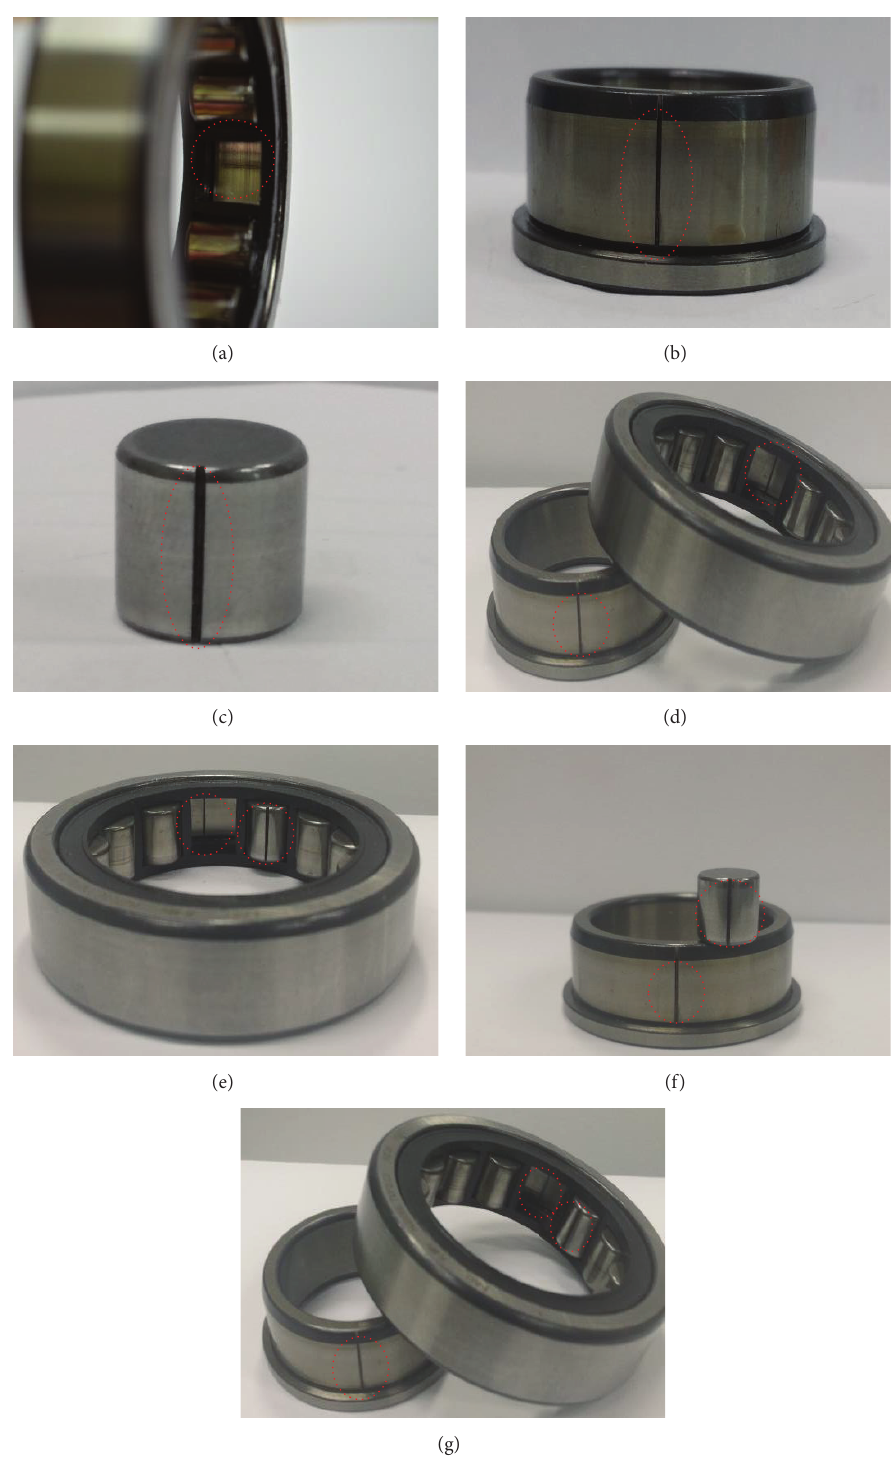
Figure 5: Single and multiple-combined bearing defects. (a) BCO, (b) BCI, (c) BCR, (d) BCOI, (e) BCOR, (f) BCIR, and (g)